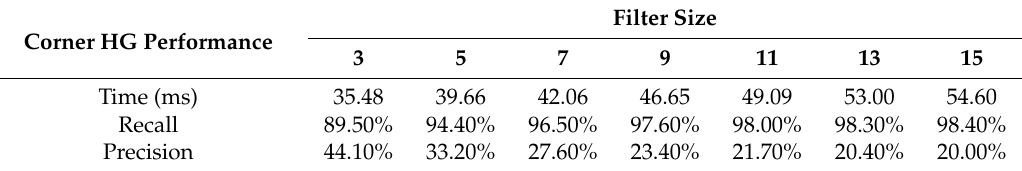
Table A1. Corner HG performance according to the dilation filter size with the training DB.